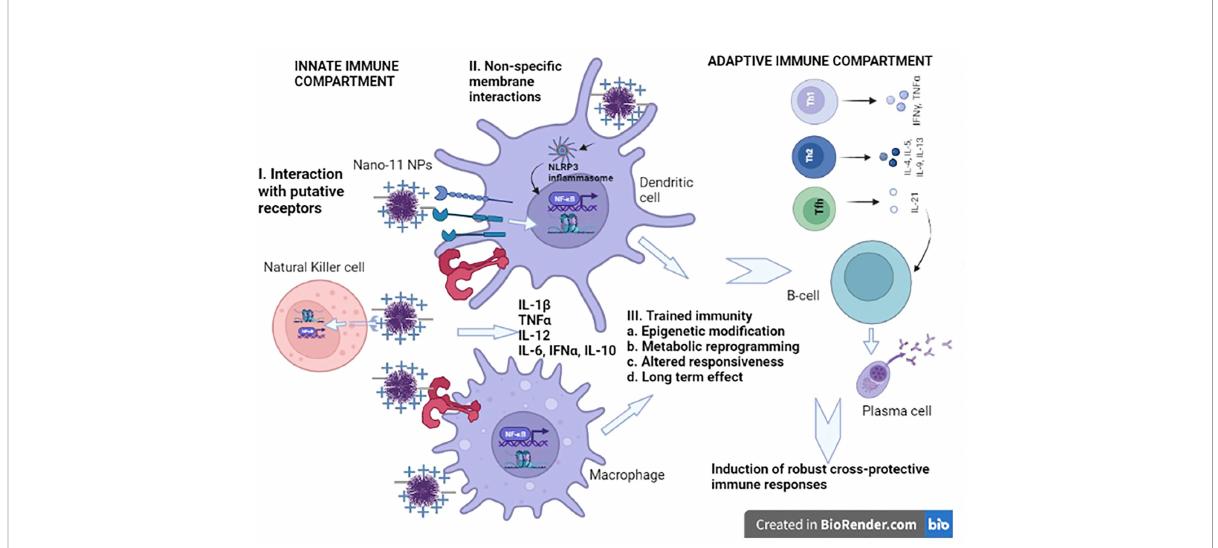
FIGURE 1 Summary of putative mechanisms of action of Nano-11 nanoparticles. Nano-11 NPs may exert their effects using three non-mutually exclusive modes. 1. Nano-11 could be recognized directly or indirectly by receptors such as NLRP3, dectin-1, dectin-2, DC-SIGN, complement receptor 3 (CR3), and TLRs. 2. Nano-11 may also mediate non-speci fi c electrostatic membrane pertubations triggering intracellular signal transduction. 3. Nano-11 may elicit trained immunity via epigenetic modi fi cation, metabolic reprogramming, altered responsiveness leading to long lasting effects involving myeloid cells. These mechanism may lead to the induction of balanced Th1 and Th2 cytokines and induction of T follicular helper (Tfh) cells cells resulting in the elicitation of strong cross-protective immune responses. This model is based on both experimental evidence and hypotheses formulated from published